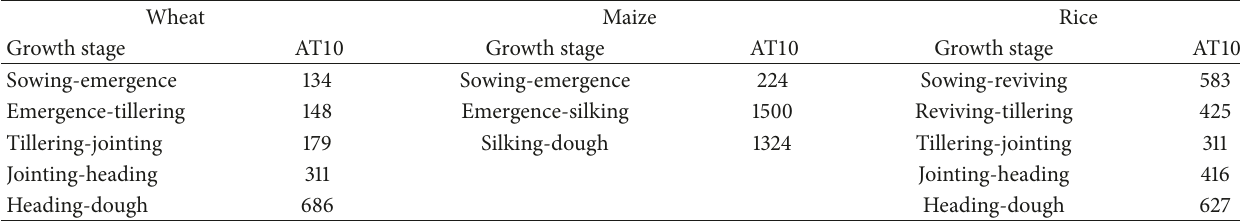
Table 3: AT 10 thresholds of major crops at different growth stages [33,